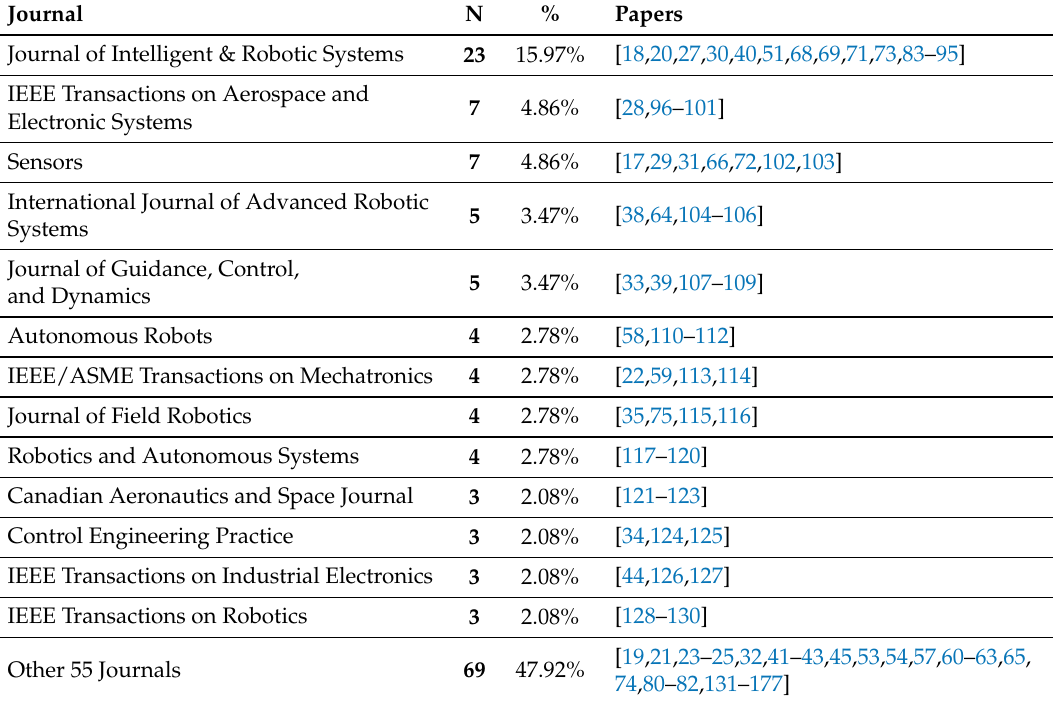
Table 3. List of the most popular publication venues.